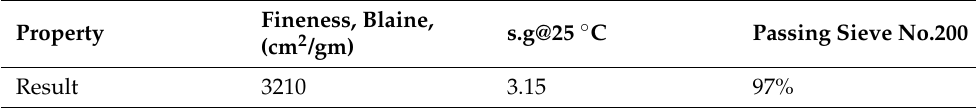
Table 10. Physical characteristics of DSO. Table 6. Physical characteristics of the Portland cement as filler.